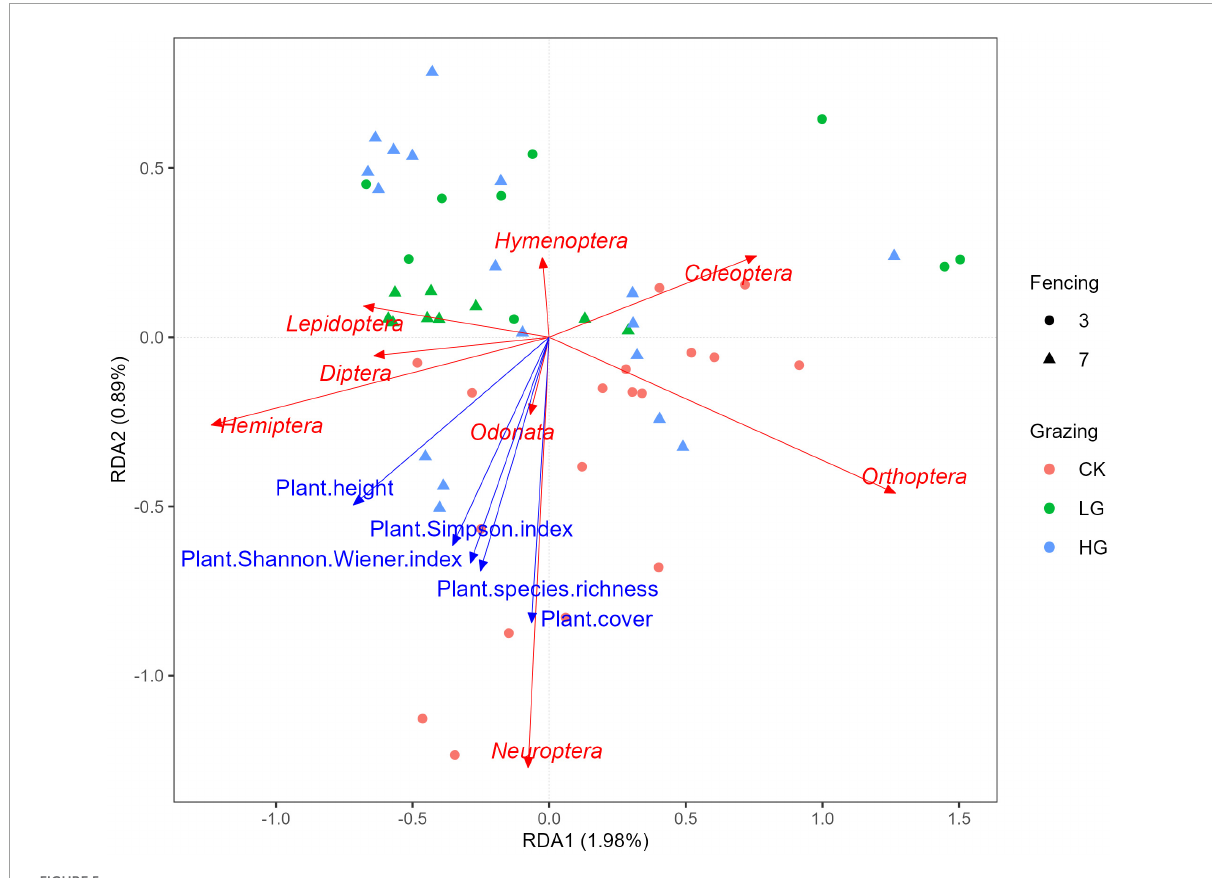
FIGURE5 Effects of plant attributes on insect abundance based on redundancy analysis